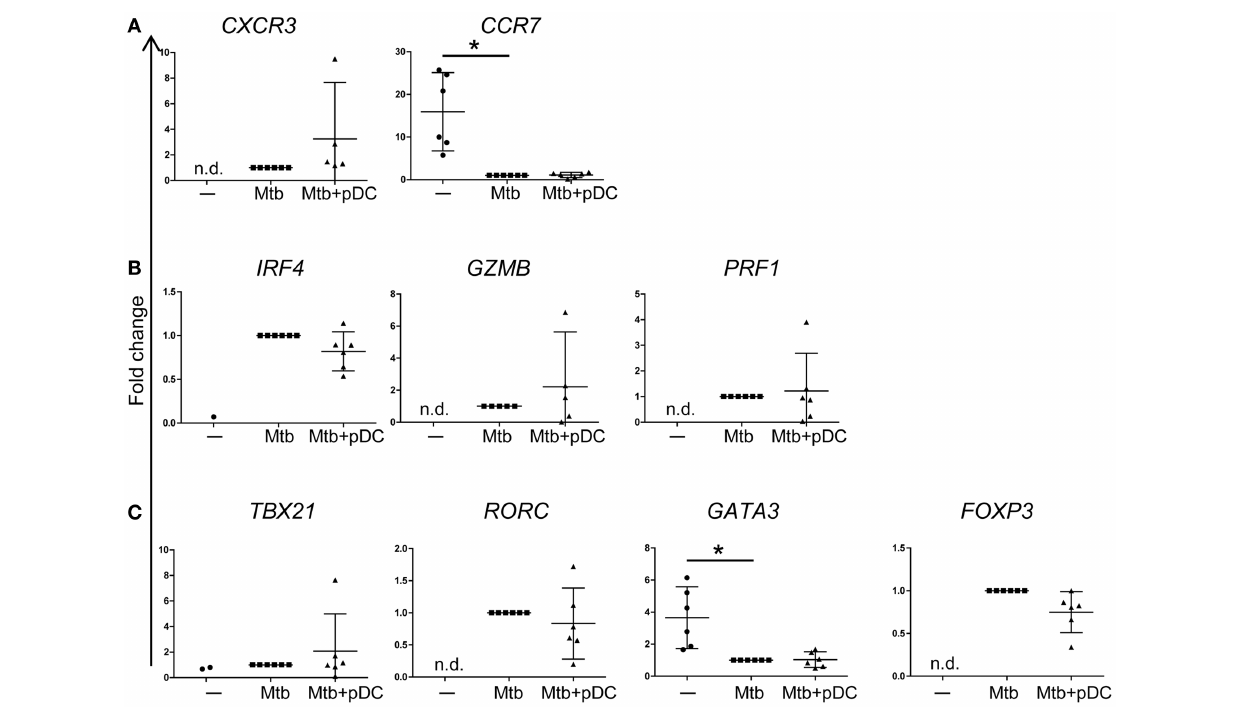
FIGURE 6 | Gene expression profile of CD4 + T cells . Fold changes of (A) CXCR3 , CCR7 , (B) IRF4 , GrB ( GZMB ), perforin ( PRF1 ), (C) Tbet ( TBX21 ), ROR γ T ( RORC ), GATA3 , and FOXP3 transcripts, measured in CD4 + CD3 + CFSE low cells, in the presence (Mtb + pDC) or absence of pDCs (Mtb) and unstimulated CD4 + CD3 + cells ( − ).The threshold for ∆ Ct calculation was set at Ct < 30 and Ct values > 30 were excluded. ∆ Ct was calculated to GAPDH. To compare data from different donors and chips, fold change in transcripts